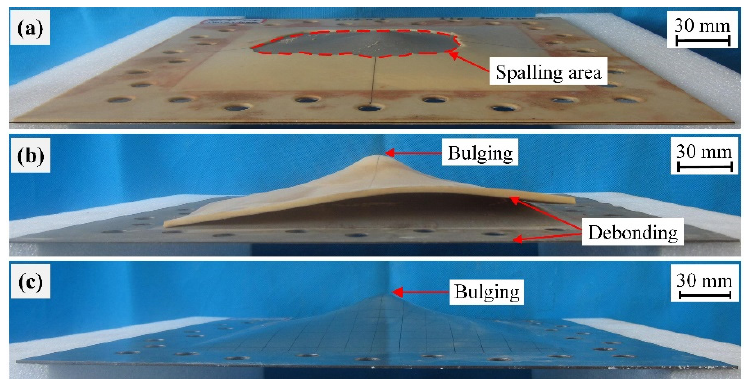
Figure 8. Photographs of the damaged plates ( a ) SPW ‐ 3, ( b ) SPP ‐ 3, and ( c ) BS ‐ 3 (from Ref. [47]) tested at a stand ‐ off distance of 150 mm.